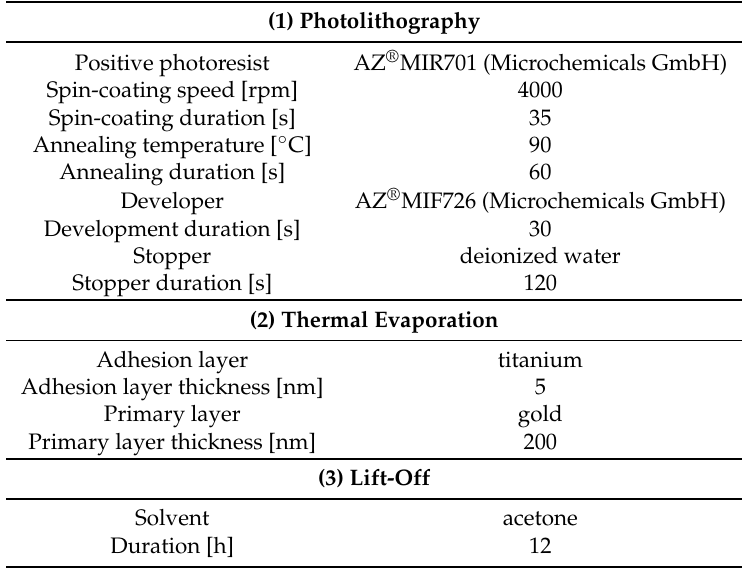
Table A2. Process parameters for the fabrication of gold electrodes.